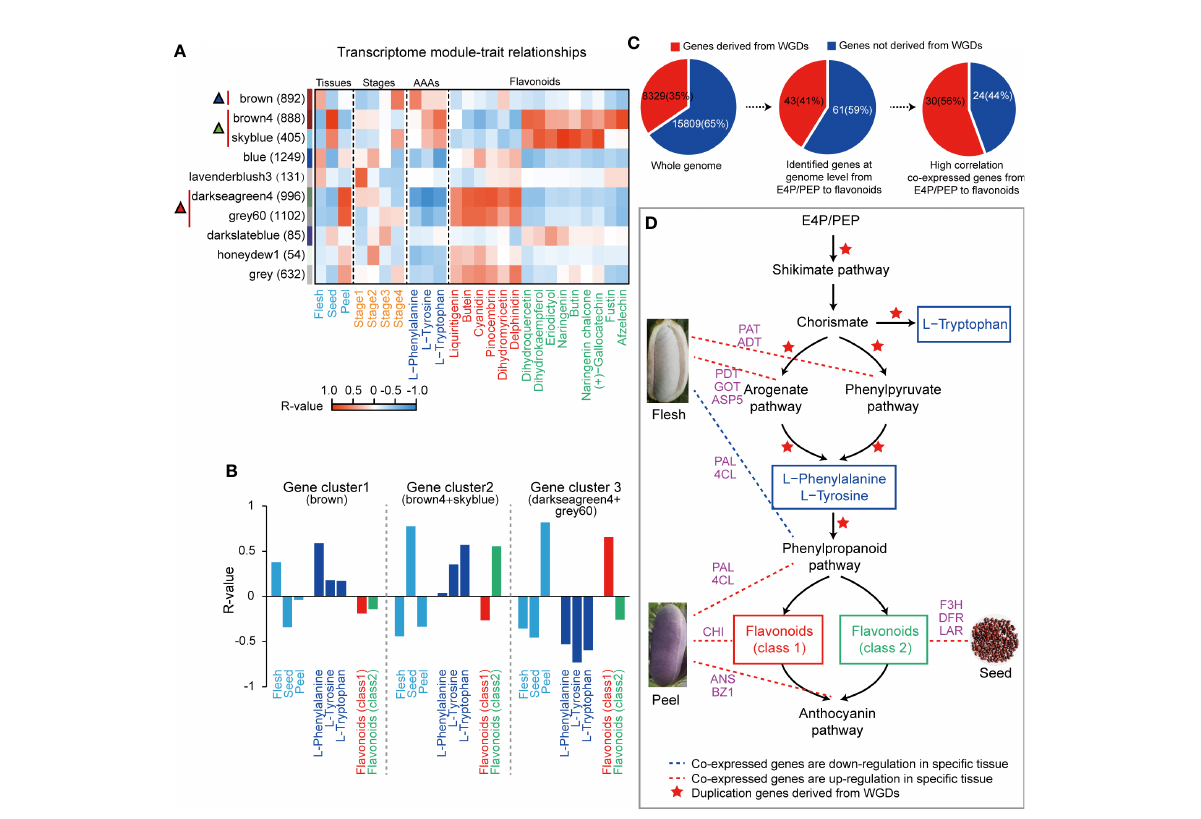
FIGURE 2 Aromatic amino acid biosynthesis and metabolism in A. trifoliata . (A) Heatmap correlation between the WGCNA gene set module and objective traits. The red vertical line and triangle marker represent the high positive module, and the numbers in brackets are the numbers of genes in each module. Flavonoids were divided into two classes by R-values. (B) Association of selected WGCNA modules with different tissues and metabolites. Mean R-values presented in the two integrated modules. (C) Percentage of genes derived from WGD events at different levels. (D) The postulated pathway for the biosynthesis of aromatic amino acids and fl